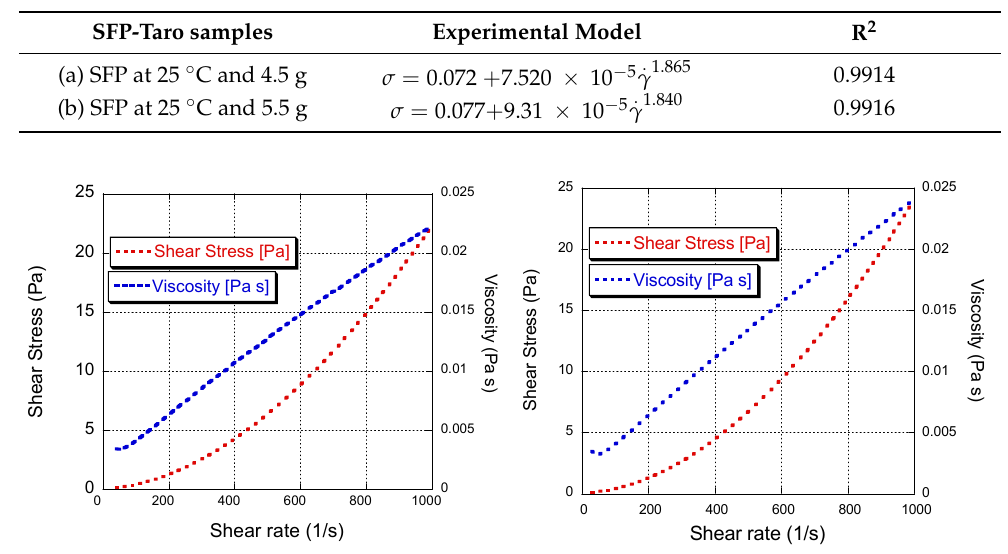
Table 4. Parameters of the steady state analysis of the Herschel–Bulkley model for water kefir (Wk) SFP .